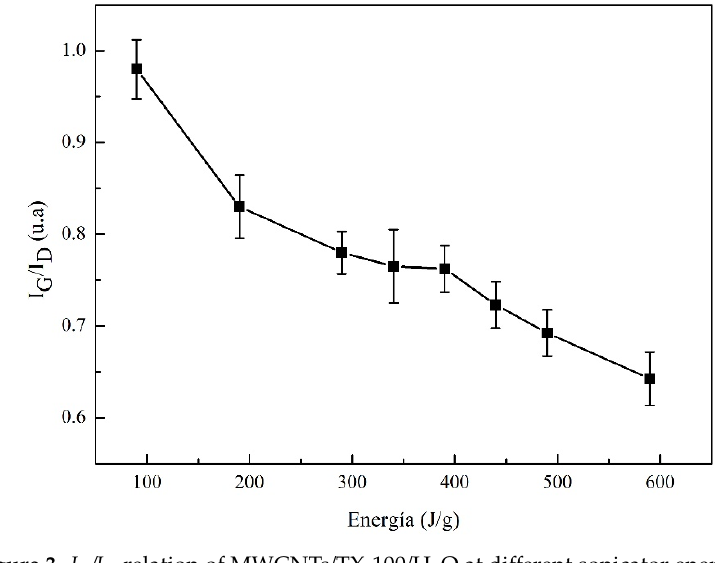
Figure 3. I G / I D relation of MWCNTs / TX-100 / H 2 O at di ff erent sonicator energies.